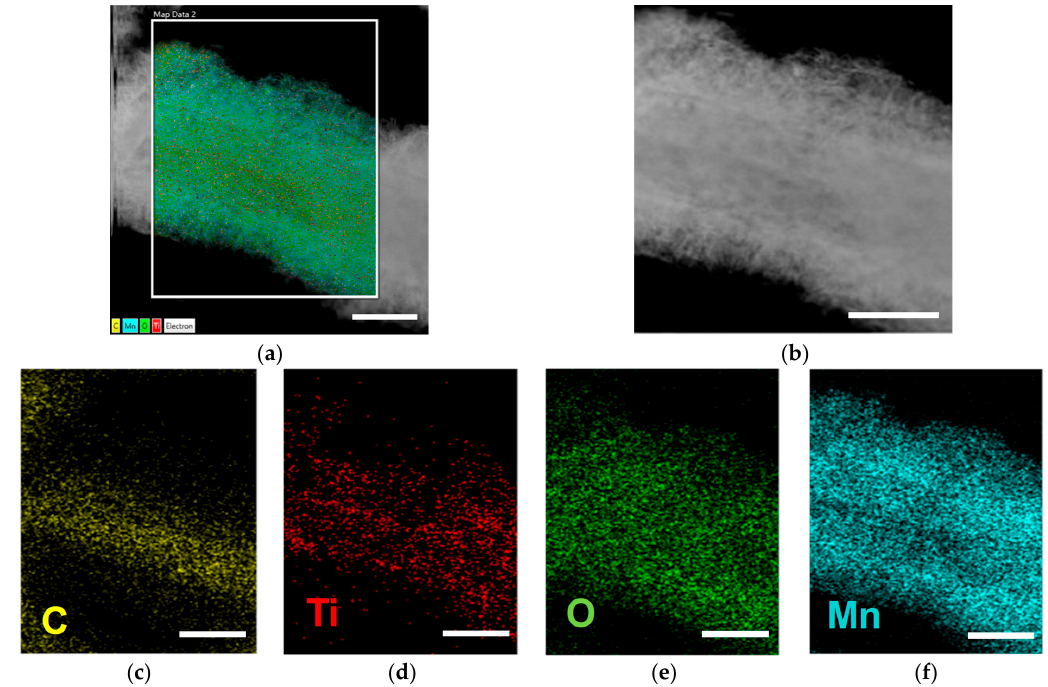
Figure 2. ( a , b ) STEM images of an individual MnO 2 -TiO 2 -carbon-47.28% composite nanofiber with the corresponding EDS elemental mapping of ( c ) C, ( d ) Ti, ( e ) O and ( f ) Mn. Scale bars = 500 nm.